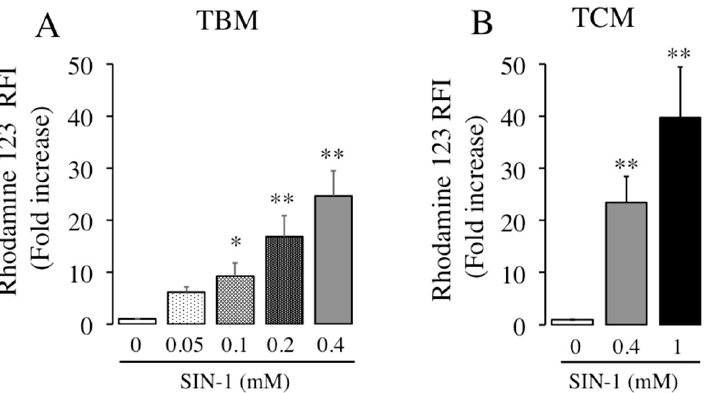
Figure 4. Concentration-dependent generation of peroxynitrite by SIN-1 in boar spermatozoa. Boar spermatozoa were incubated in TBM ( A ) or TCM ( B ) in the absence (white histograms) and presence of indicated concentrations of SIN-1 (filled histograms). The levels of reactive nitrogen species (RNS) induced by SIN-1 were evaluated by flow cytometry using DHR 123 as a probe. These experiments were performed 6 times ( n = 6) and results are expressed as the fold increase of Relative Fluorescence Intensity (RFI) of DHR 123 ± SEM. Statistical di ff erences are shown with * ( p < 0.05) and ** ( p <